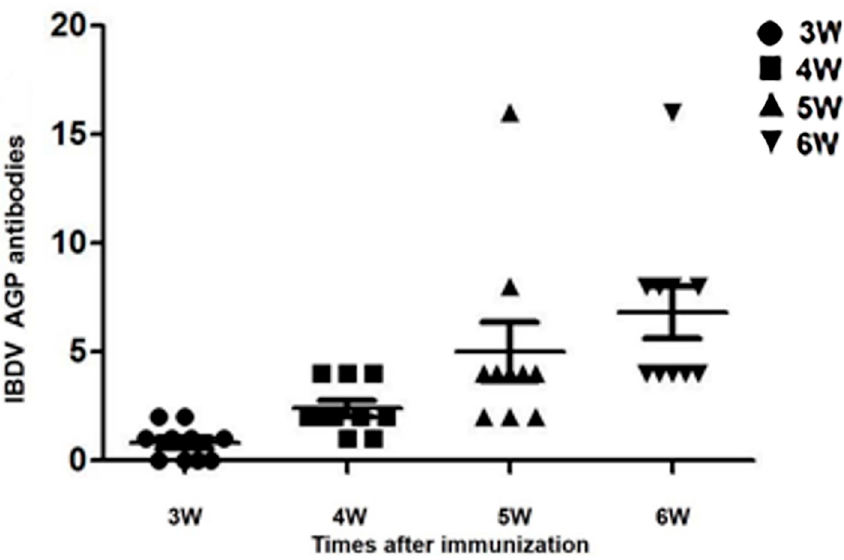
Figure 8. IBDV AGP antibodies after immunization with HVT-VP2-09. The maximum dilution of IBDV AGP antibodies was tested at 3, 4, 5, and 6 weeks after inoculation with HVT-VP2-09. IBDV AGP antibodies were not detected in the other groups (not